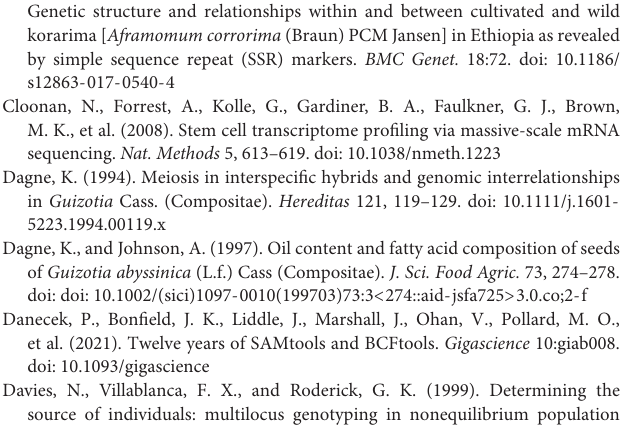
Supplementary Figure 1 | Graphs depicting three clusters ( K = 3) as the best representation of (A) the 28 noug genotypes based on 5,531 SNP loci, and (C) the 30 genotypes based on 1,687 SNP loci, using the method of Puechmaille (2016) for the determination of the optimum number of clusters; and the corresponding graphical display of the genetic structure of (B) 28 noug genotypes and (D) 30 noug genotypes generated based on genotypic data at 5,531 and 1,687 SNP loci, respectively, following the determination of the optimum number of clusters (K) of three ( K = 3) using the method. The three colors in (B) and (C) correspond to the three clusters (genetic populations) and the proportion of each color in each genotype denotes the average proportion of the alleles that placed each accession under the three clusters. Supplementary Table 1 | Plant material (genotypes) used for this study and their general description. Supplementary Table 2 | The list of SSRs detected within the 35639 Unigenes and their descriptions. Supplementary Table 3 | List of the 5531 SNP loci that passed the quality filtering criteria and recorded accross 28 noug genotypes, together with their SNP position (POS), reference allele (REF), alternative allele(s) (ALT), quality score, (QUAL), polymorphic information content (PIC), Observed heterozygosity (Ho), expected heterozygosity (He), P -value for Hardy-Weinbeg Equlaibrium (HWE P -value) and corrsponding reference unigene sequence. Supplementary Table 4 | List of SNP loci that showed signfcant deviation from Hardy-Weinberg Equlibrium (HWE), under the assumption that the 28 genotypes represent a single population, together with their SNP position (POS), reference allele (REF), alternative allele(s) (ALT), Observed heterozygosity (Ho), expected heterozygosity (He), Ho-He and P -value for Hardy-Weinbeg Equlaibrium (HWE P -value). Supplementary Table 5 | The pairwise Nei’s standard genetic distance between the 28 noug genotypes calculated based on 5531 SNP loci. The diagonal values are mean genetic distance of each genotype from all other genotypes. The Pearson correlation coefficent between the mean genetic distance for 28 genotypes (5531 polymorphic loci) and the 30 genotypes (1687 polymorphic loci) was 0.955 ( P <